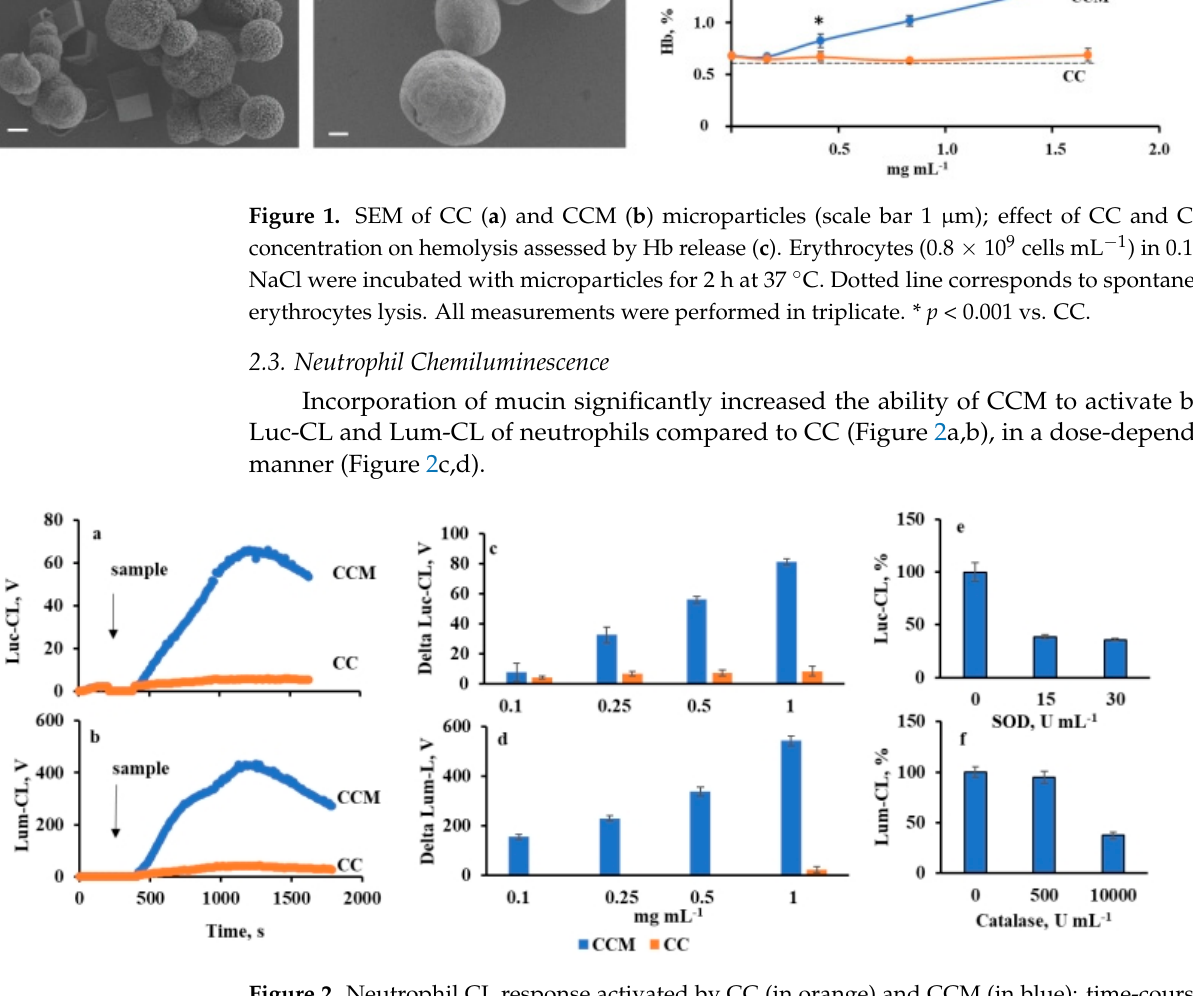
Figure 1. SEM of CC ( a ) and CCM ( b ) microparticles (scale bar 1 µm); effect of CC and CCM con- centration on hemolysis assessed by Hb release ( c ). Erythrocytes (0.8 × 10 9 cells mL − 1 ) in 0.15 M NaCl were incubated with microparticles for 2 h at 37 °C. Dotted line corresponds to spontaneous erythrocytes lysis. All measurements were performed in triplicate. * p < 0.001 vs. CC.